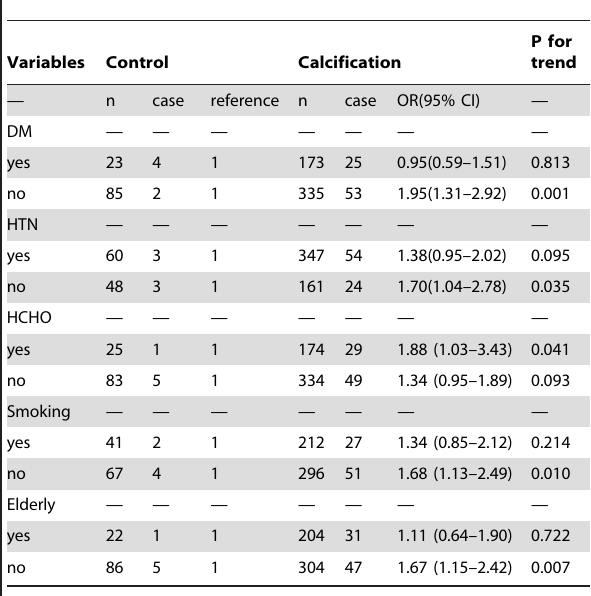
Table 6. Subgroup analysis of the effect of coronary plaque calcification per patient on periprocedural myocardial infarction in logistic regression